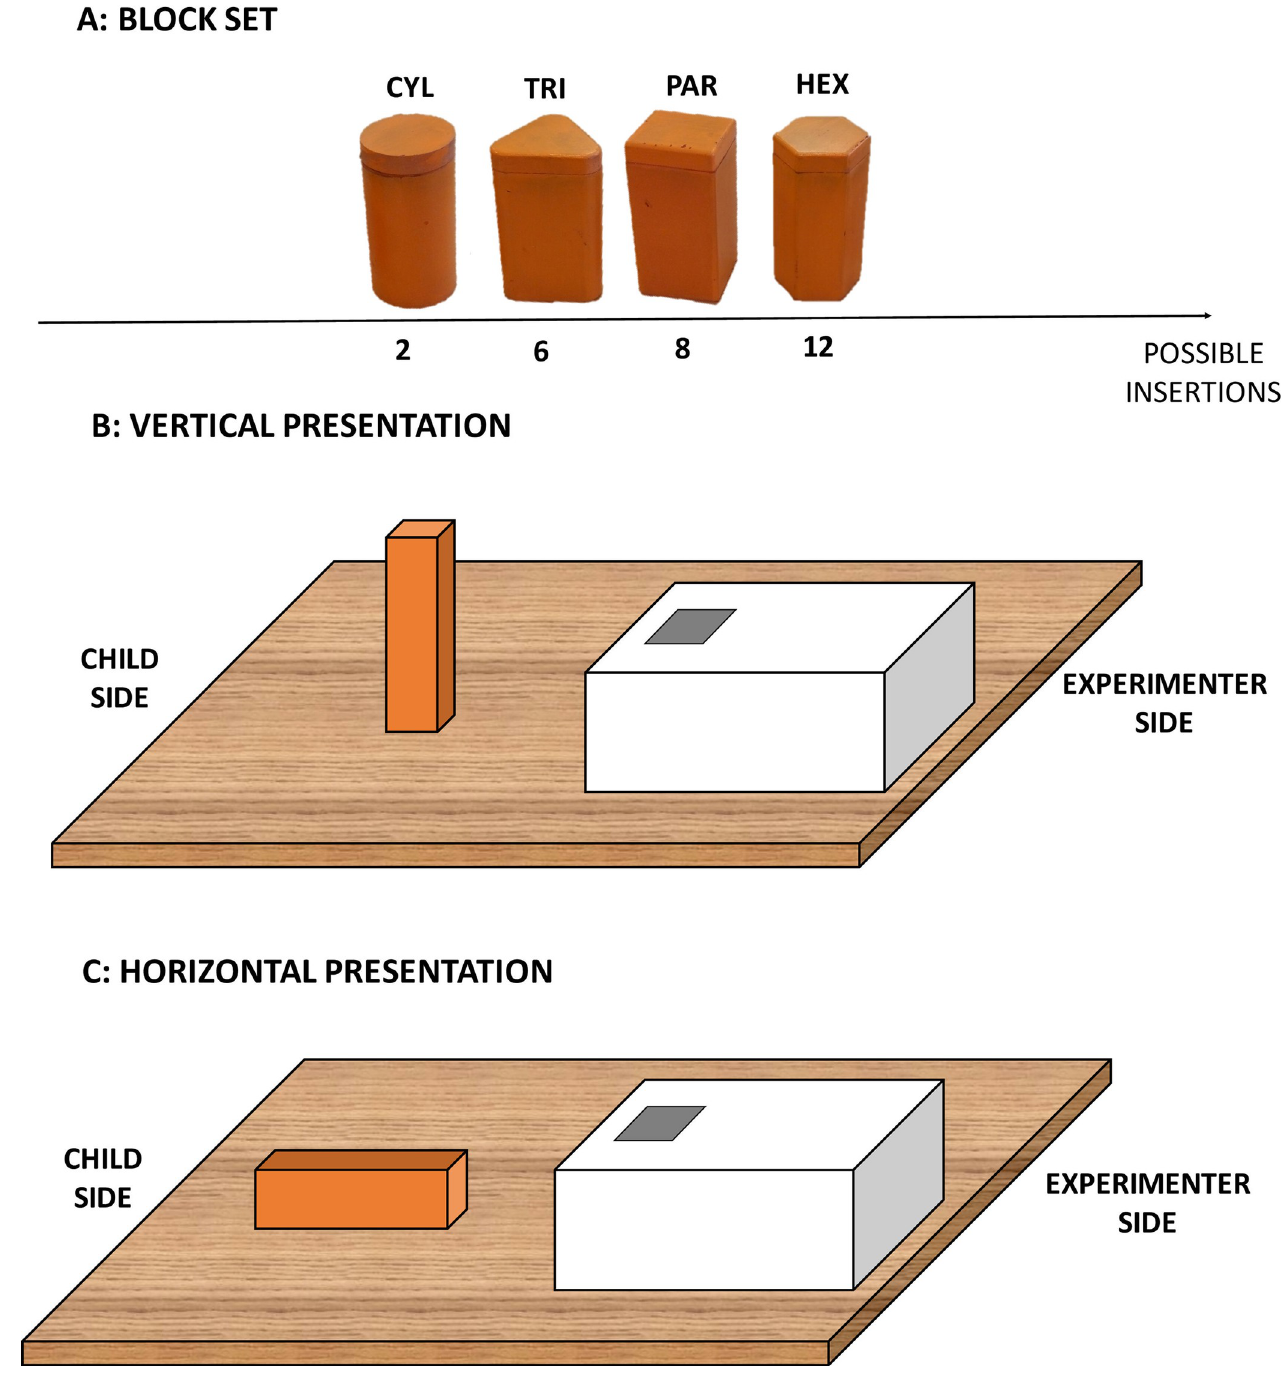
Fig 1. The shape sorter protocol. A) Blocks used in the protocol. The cross section of each block defines the possibilities of insertion into the aperture: the cylinder may be inserted in two ways, from the upper base or from the lower base; the triangular prism in six ways, three for each base; the parallelepiped in 8 ways, 4 for each base; and the hexagonal prism in 12 ways, six for each base. B) and C) show examples of vertical and horizontal orientation of the parallelepiped block respectively.